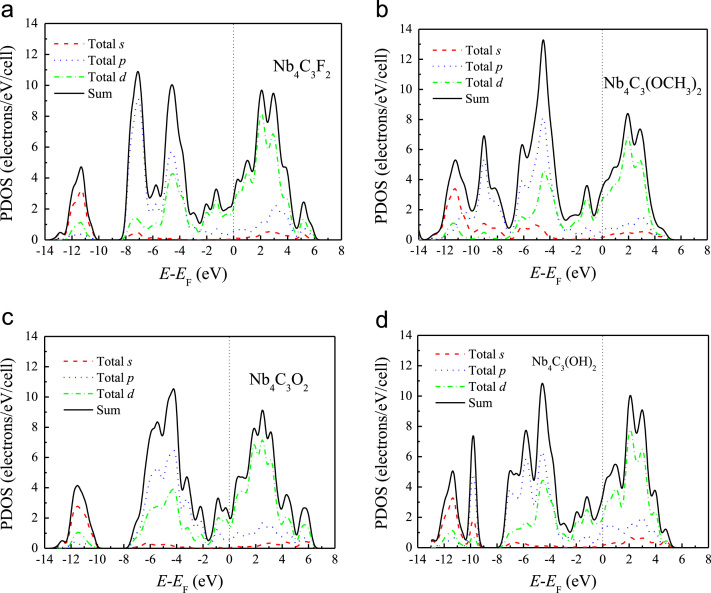
The PDOS of (a) Nb4C3F2, (b) Nb4C3(OCH3)2, (c) Nb4C3O2, and (d) Nb4C3(OH)2.